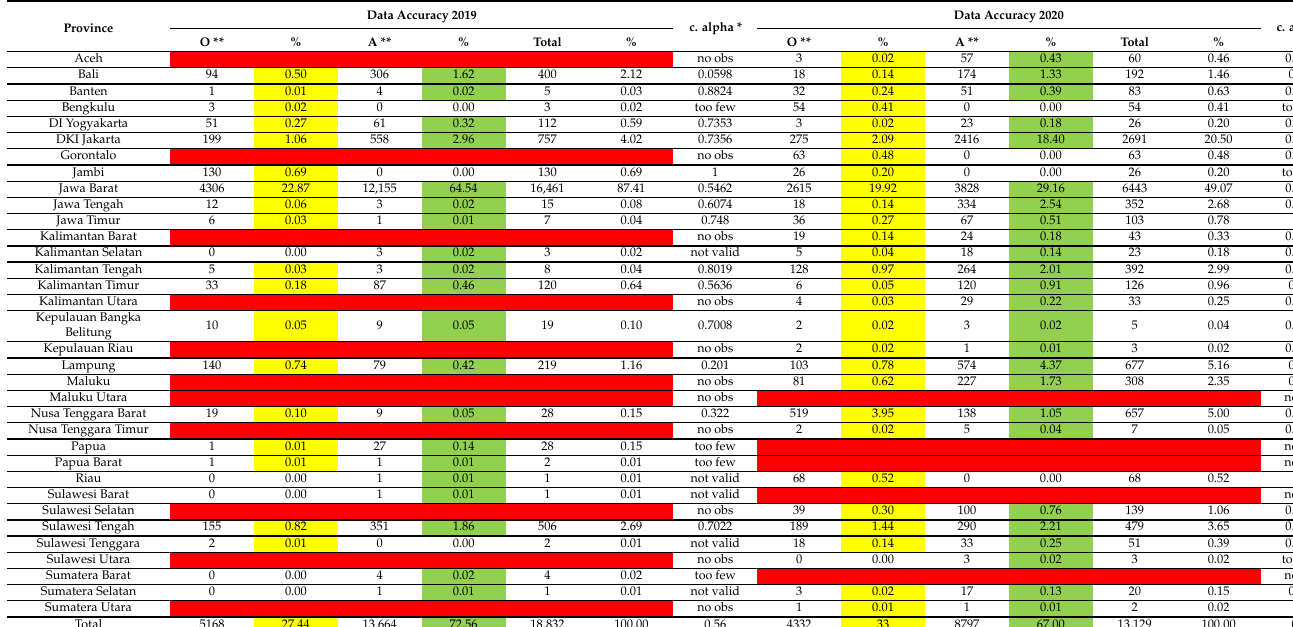
Table 4. Data accuracy and consistency per province